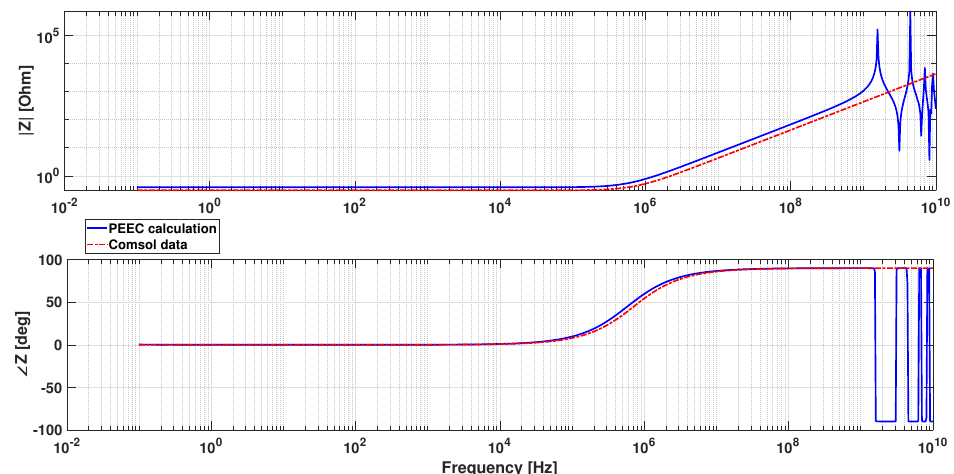
Figure 22. Frequency response of the excitation coil impedance calculated with the PEEC filamentary model (solid blue line) and with resistance and inductance parameters estimated in Comsol (dashed- dotted red